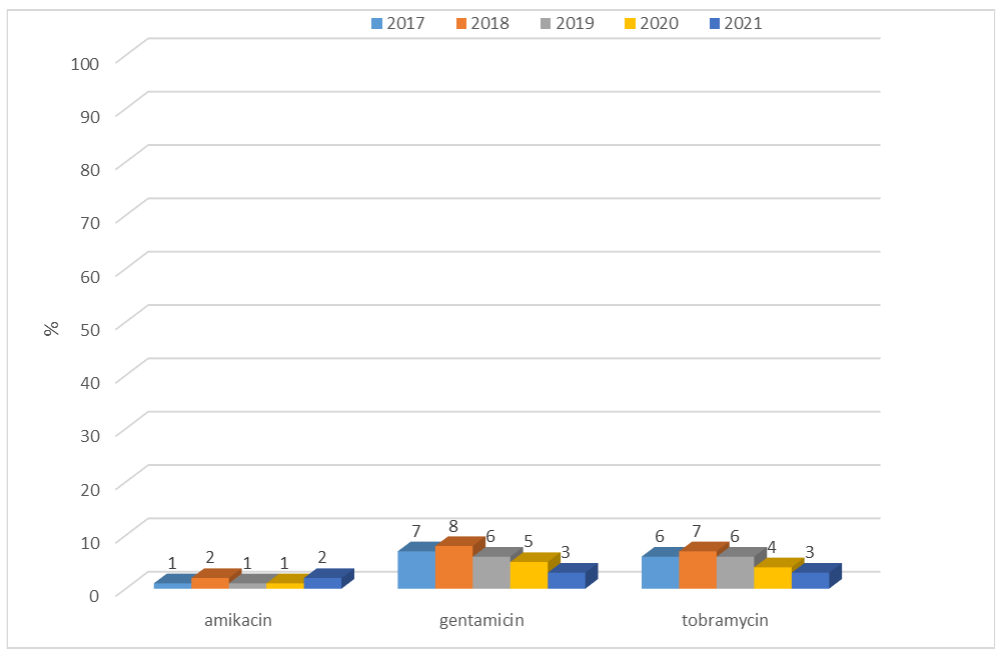
Figure 7. Percentage of aminoglycoside-resistant E. coli ESBL(−) strains.